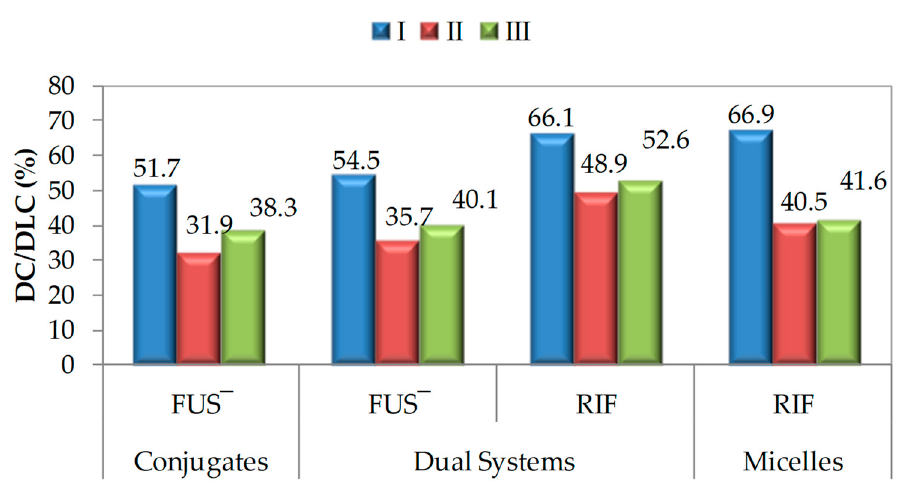
Figure 2. DC/DLC values of FUS or RIF for various carriers based on graft copolymers I–III, where: DC refers to the amount of conjugated ionic drug, and DLC relates to the amount of non-ionic drug encapsulated in the micelle core.